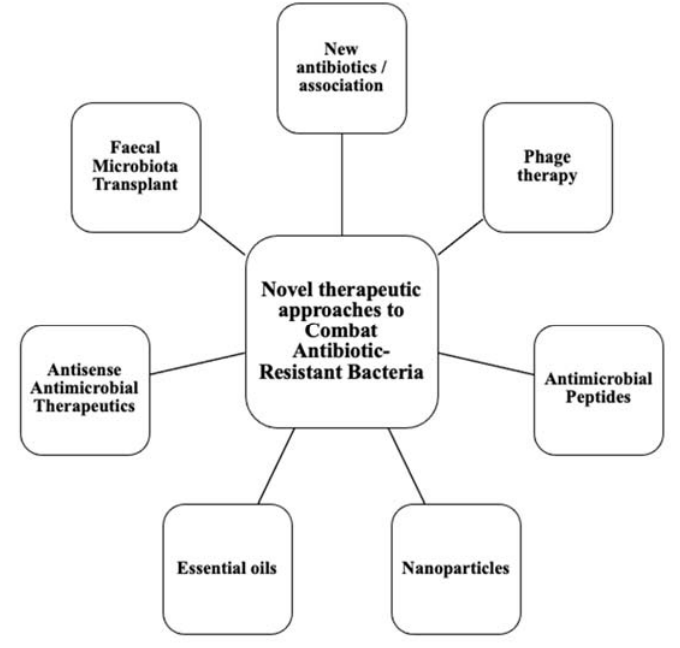
Figure 2. Alternatives therapeutic approaches to conventional antibiotics.